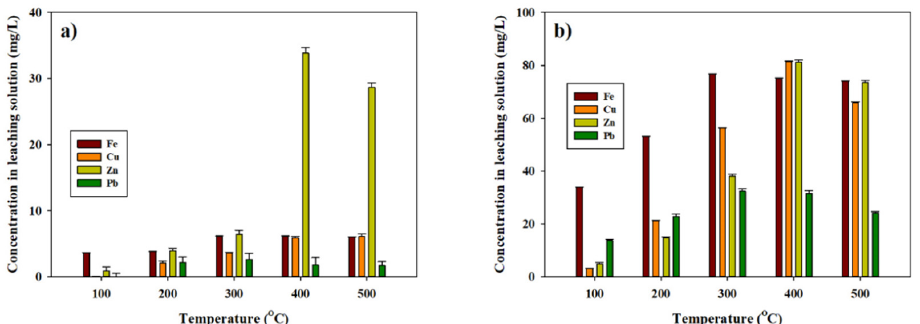
Figure 6. Concentration of Fe, Cu, Zn, and Pb in leaching water from the hot water leaching process after ( a ) roasting or ( b ) acid baking at different temperatures from 100 °C to 500 °C.